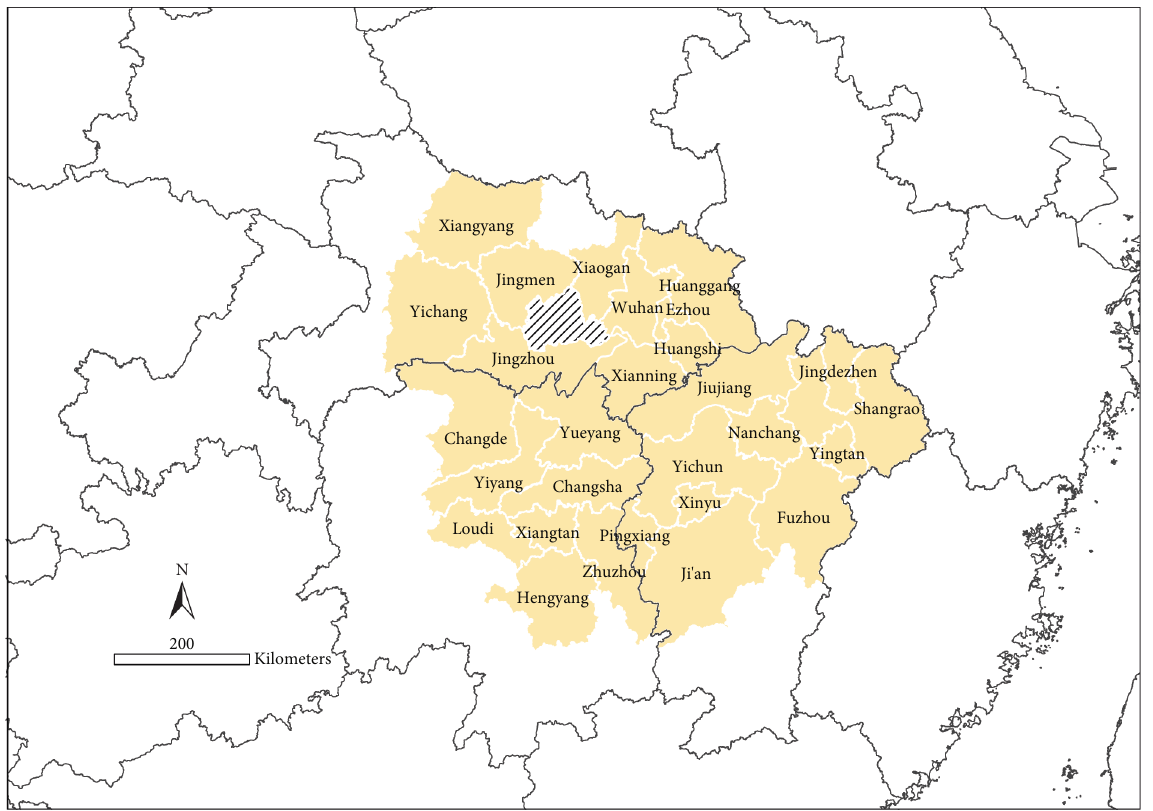
Figure 1: Research